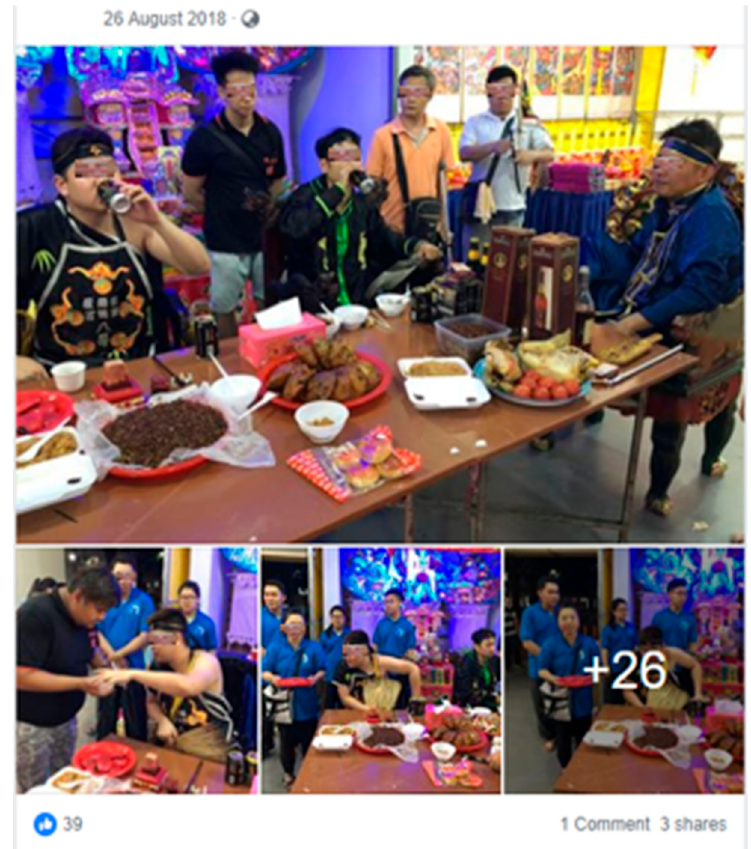
Figure 5. A Facebook Post Containing Photographs from a Sintua’s Celebration of their Deity’s Birthday. The photos here show the deities enjoying the religious merriment with each other, and interacting with their devotees as well. The faces of people have been pixelated to protect their anonymity.